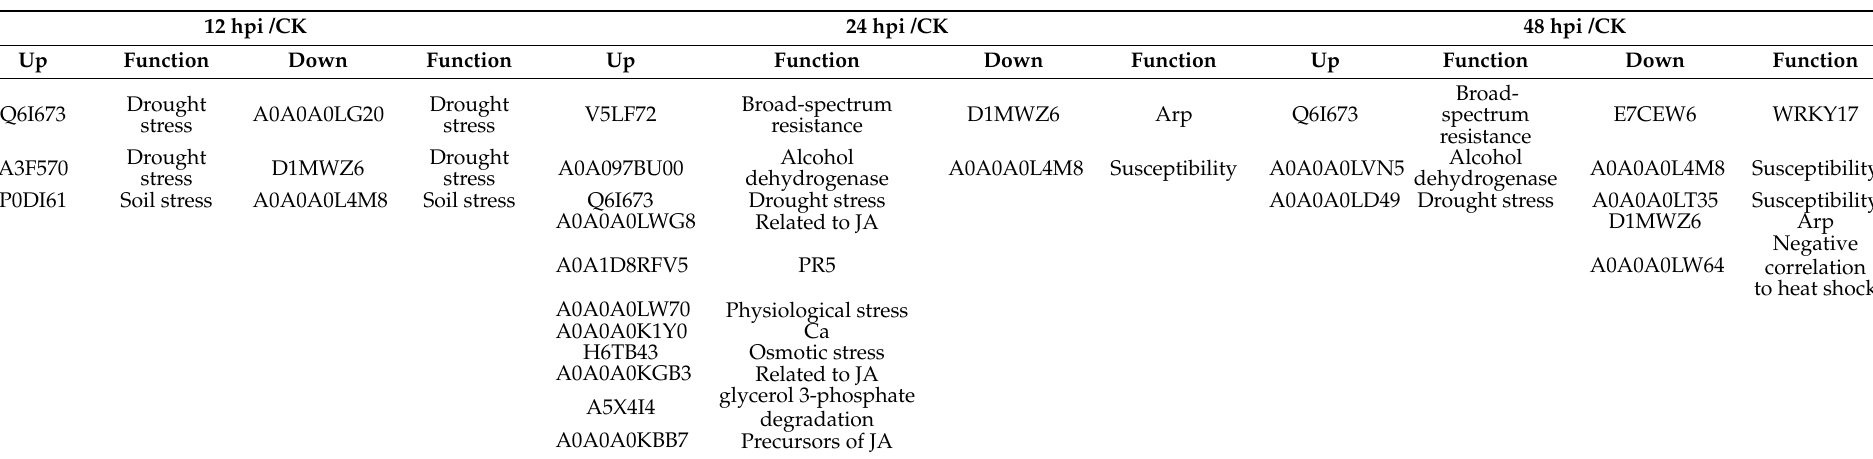
Table 2. Function analysis of differentially expressed